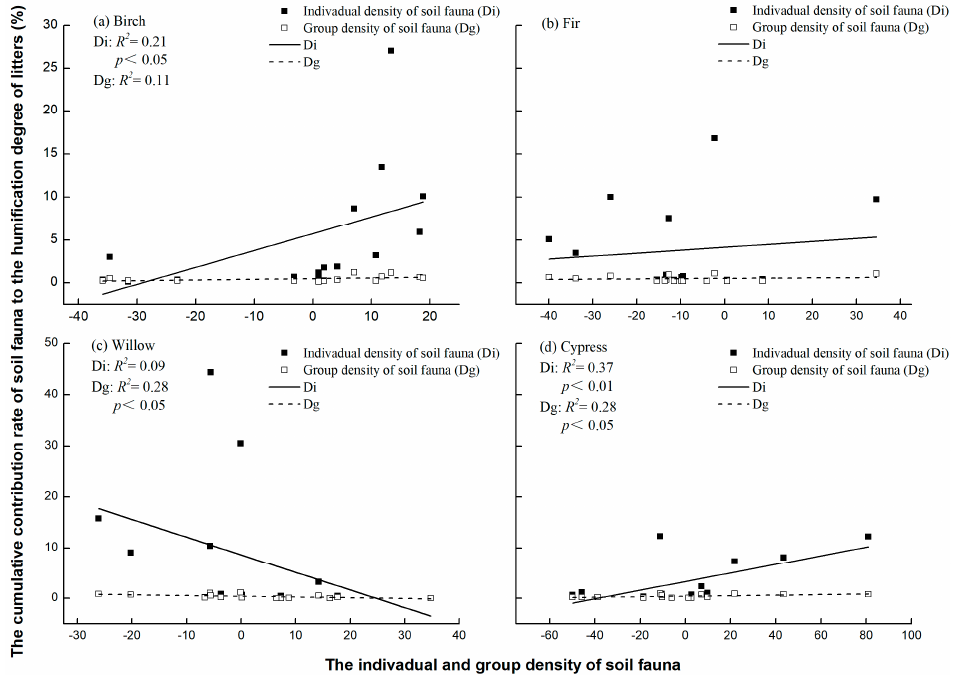
Figure 8. Linear regression analysis between the cumulative contribution rate of soil fauna to the humification degree of four kinds of litters and the individual and group density of soil fauna.